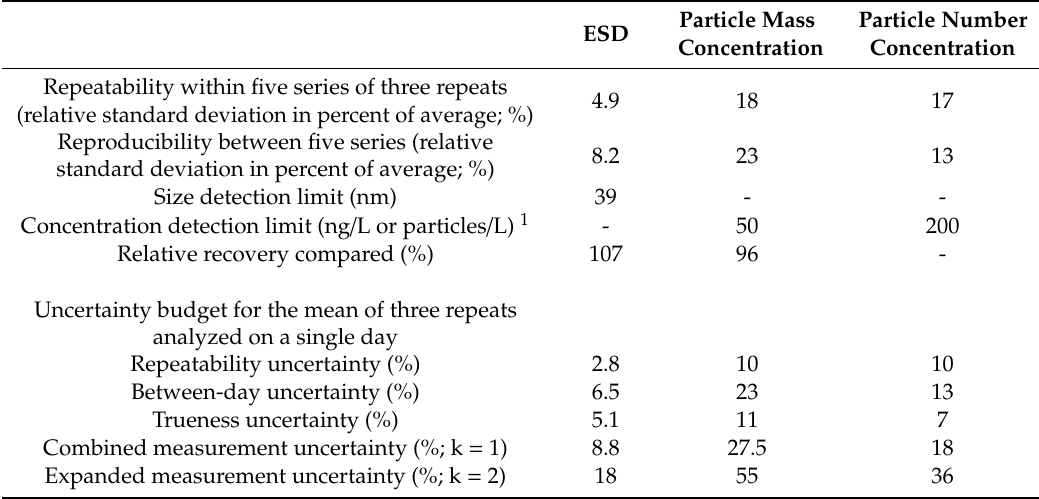
Particle Mass Particle Number ESD Concentration Concentration 4.9